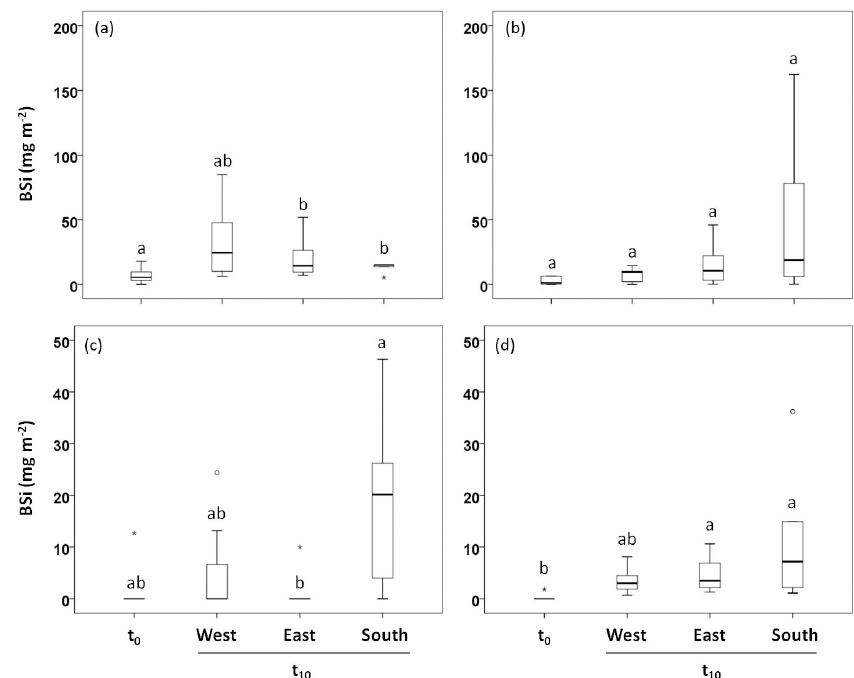
Figure 4. Box plots (top, middle and bottom lines of the boxes show the 25th, 50th and 75th percentiles and whiskers represent 1.5 × the interquartile ranges) of biogenic Si pools in soils (upper 5cm) at Chicken Creek at the end of construction work ( t 0 ) and after 10 years of ecosystem development (western, eastern and southern sections, t 10 ). (a) Phytogenic Si pools (phytoliths), (b) protophytic Si pools (diatom frustules), (c) zoogenic Si pools (sponge spicules) and (d) protozoic Si pools (testate amoeba shells). Significant differences are indicated by different letters ( p <0.05, Kruskal–Wallis ANOVA with Dunn’s post hoc test). Circles and asterisks indicate outliers and extreme values, respectively. Note different scales for diagrams (a) and (b) and (c) and (d) .